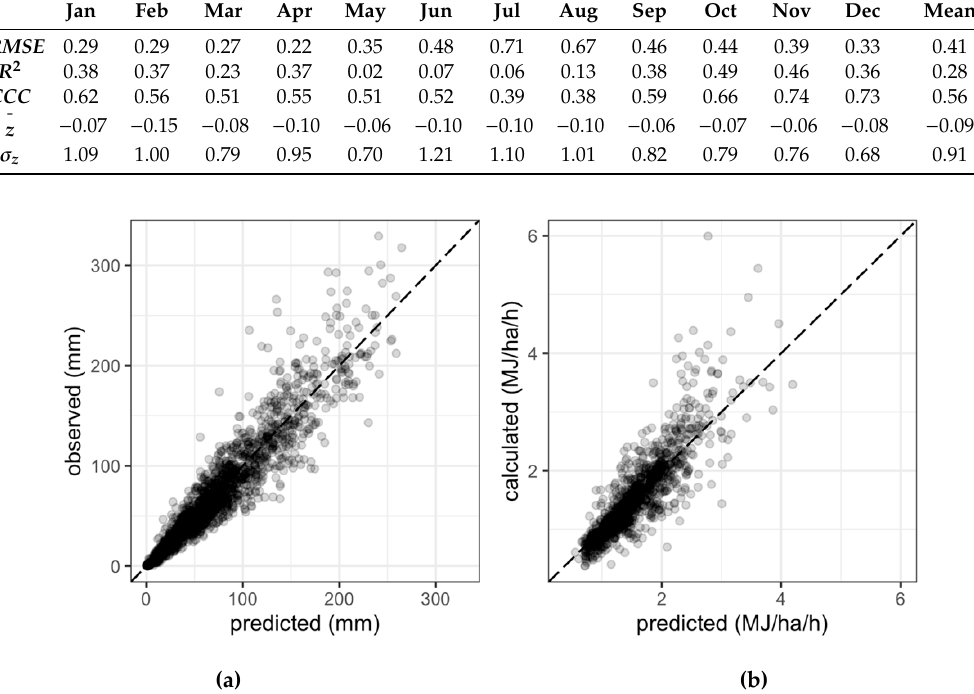
Figure 4. Scatterplots based on the results from ten-fold cross validation for: ( a ) Predicted vs. observed precipitation monthly values; ( b ) Predicted vs. calculated ED monthly values. Black line symbolized the identity function f(x) = x .